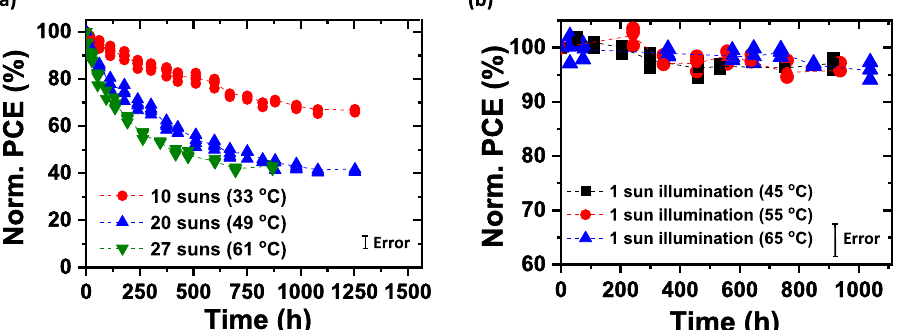
Fig. 2 OPV ef fi ciency under accelerated aging conditions. a Normalized PCE plotted vs. aging time under illumination equivalent to 10 ± 1.2, 20 ± 2.5, and 27 ± 3.8 suns. b Normalized PCE plotted vs. aging time under simulated AM1.5 G one sun illumination with temperature of 45 ± 5, 55 ± 5, and 65 ± 5 °C (populations of 3 – 4 devices). The error bars indicate the 1 s.d. uncertainty of PCE